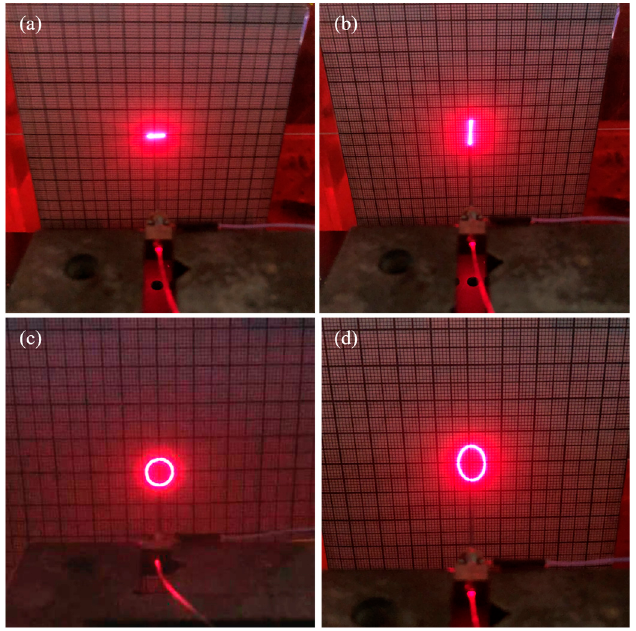
Figure 10. Photos of four types of simple scans. ( a ) Linear scanning in X direction. ( b ) Linear scanning in Y direction. ( c ) Circular scanning. ( d ) Elliptical